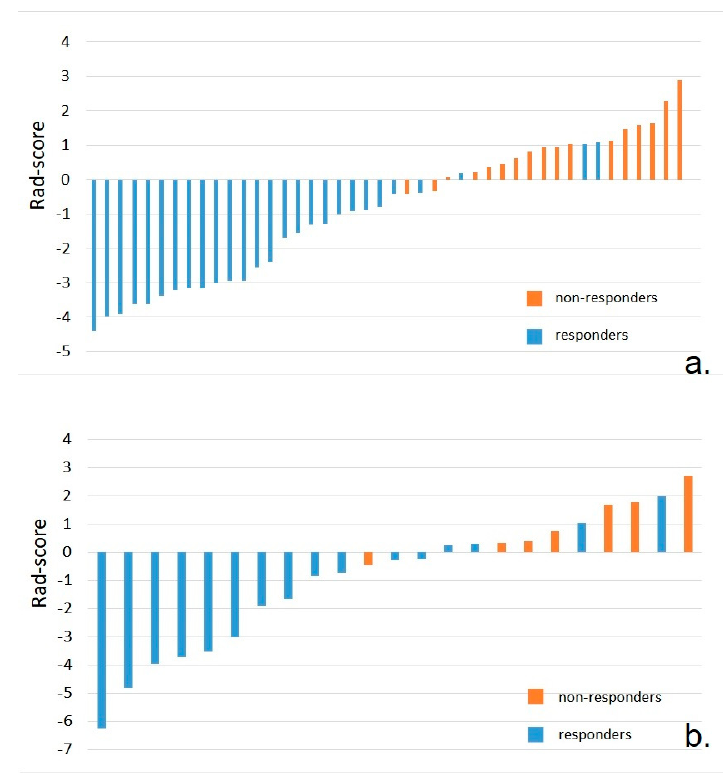
Figure 2. ( a ). Bar charts of the radiomics signature for each patient in the training set. ( b ). Bar charts of the radiomics signature for each patient in the validation set. The orange bars indicate the patients in the non-responders group, while the blue bars represent patients in the responders group.